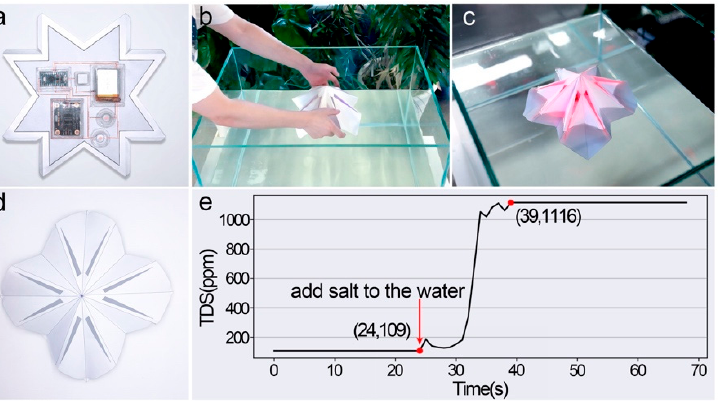
Figure 14. Total dissolved solids (TDS) detection device: ( a ) Paper circuit; ( b ) placing device in water; ( c ) red light illuminates to alert when detected TDS values exceed a set value; ( d ) folded shape of device; ( e ) values detected by device.